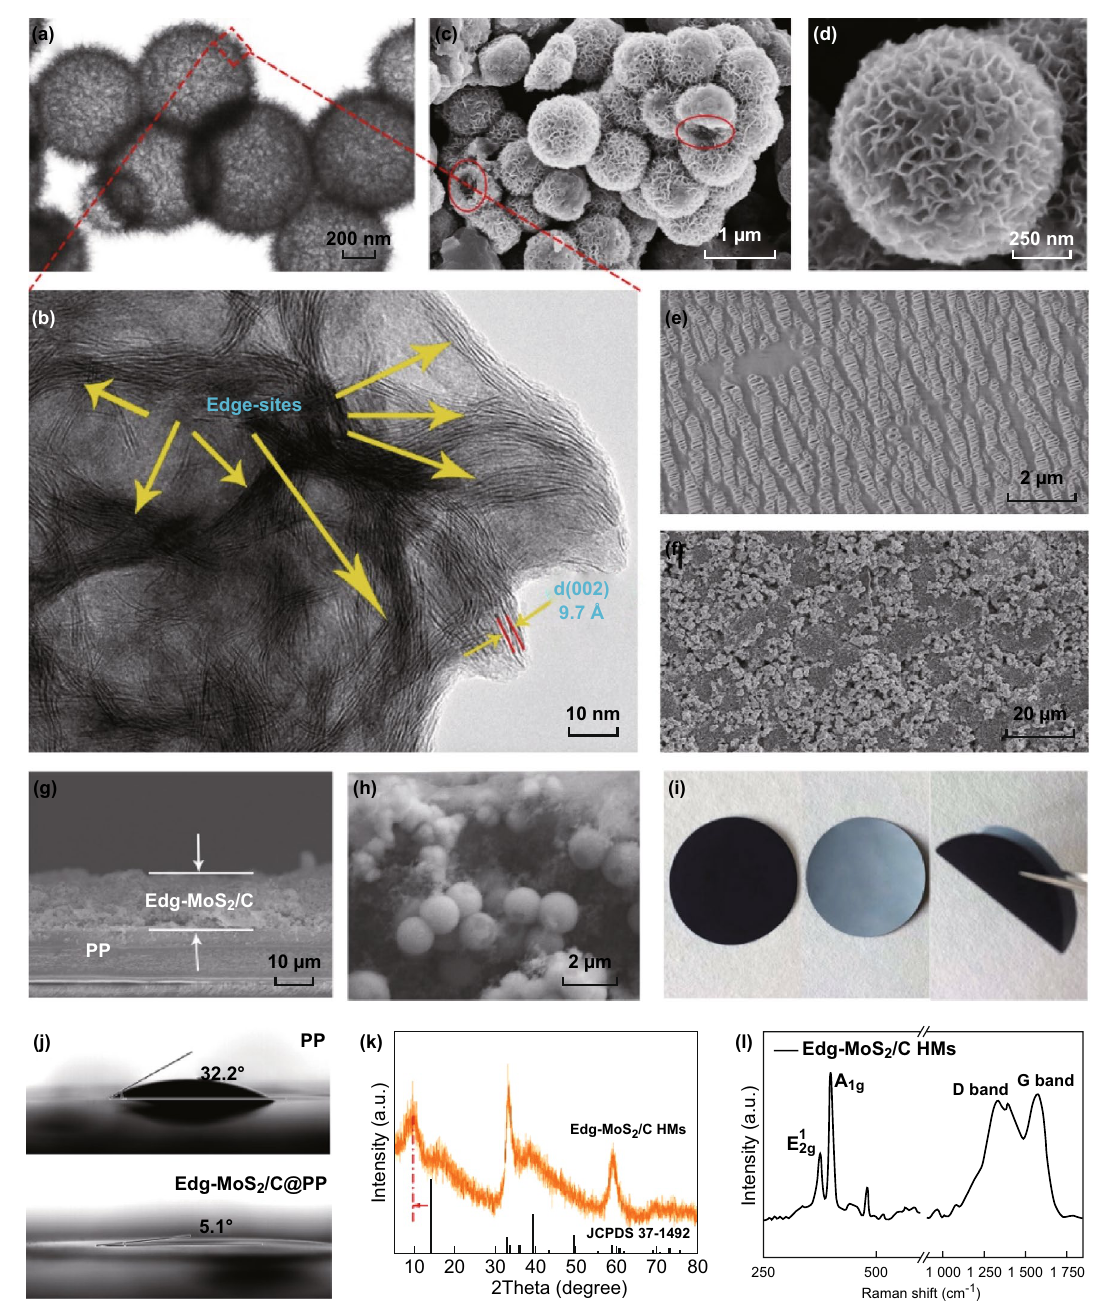
Fig. 2 Characterization of the Edg‑MoS 2 /C HMs and Edg‑MoS 2 /C@PP separators. TEM images a at low and b high magnifications, and SEM images c at low and d high magnifications of the Edg‑MoS 2 /C HMs. Top‑down SEM images of e the pristine PP separator and f Edg‑MoS 2 /C@ PP separator. g Low‑ and h high‑magnification cross‑sectional SEM images of the Edg‑MoS 2 /C@PP separator. i Optical photographs of Edg‑ MoS 2 /C@PP separator. j Contact angle between electrolyte and PP separator (top), electrolyte and Edg‑MoS 2 /C@PP separator (bottom). k XRD pattern, l Raman spectrum of the Edg‑MoS 2 /C